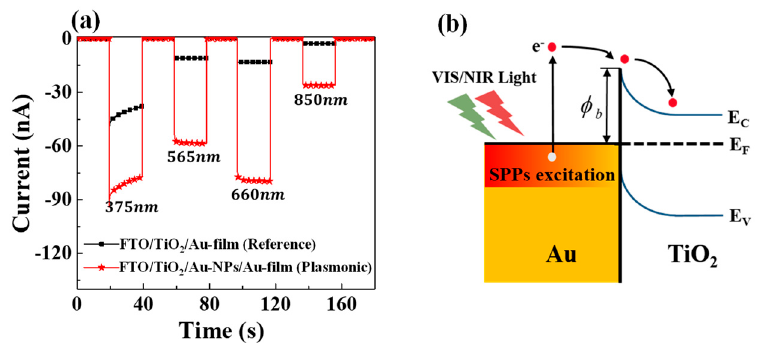
Figure 3. ( a ) Measured transient photocurrent responses ( I-t curves) of the hybrid plasmonic and reference HEPDs when the wavelength of the incident LED source is varied ( λ = 375 nm, 565 nm, 660 nm, and 850 nm). ( b ) Schematic diagram of the hot electron transfer processes over the Schottky barrier under illumination by visible/NIR light.